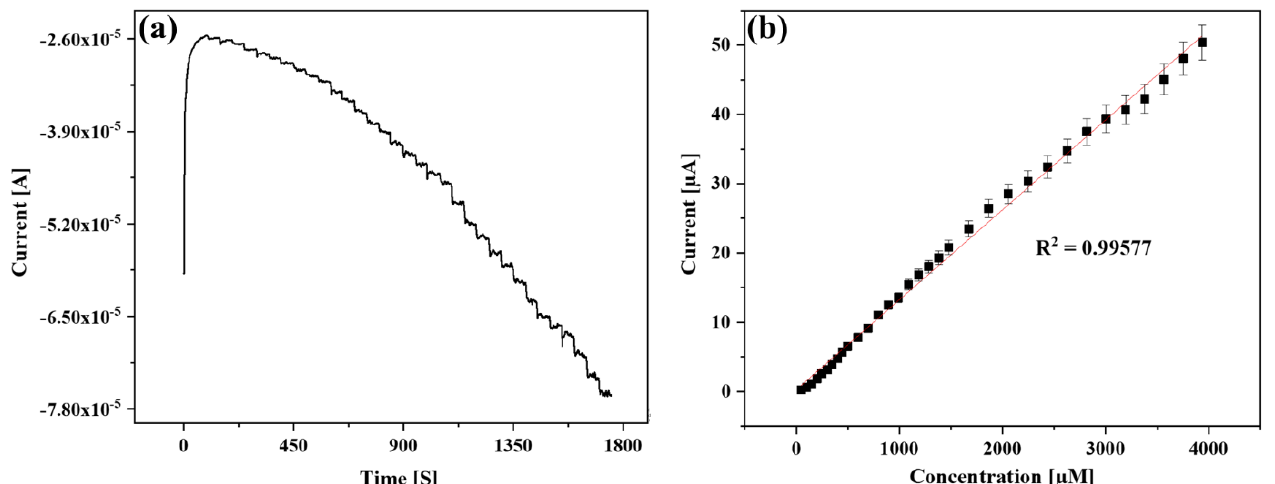
Figure 6. ( a ) Amperometry analysis curve of GCE/Au NPs/SnO 2 NFs composite electrode with continuous addition of H 2 O 2 in PBS (pH 7.0) at the potential of − 0.82 V; ( b ) corresponding current vs. concentration calibration plots.